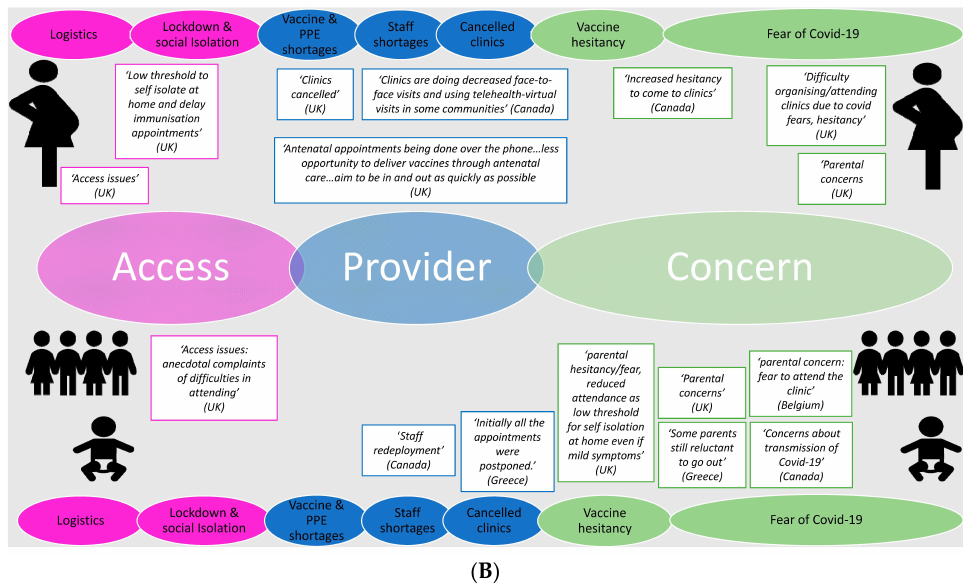
Figure 2. Factors affecting maternal (top of panel), neonatal and infant (bottom of panel) vaccine delivery as reported by respondents from ( A ) low-and-middle-income countries (LMICs) and ( B ) high-income countries (HICs). Note: Selected quotes are included from participant responses to substantiate the chosen themes and subthemes. ANC, antenatal care; TT, tetanus toxoid; PPE, personal protective equipment; COVID-19, coronavirus disease 2019 .